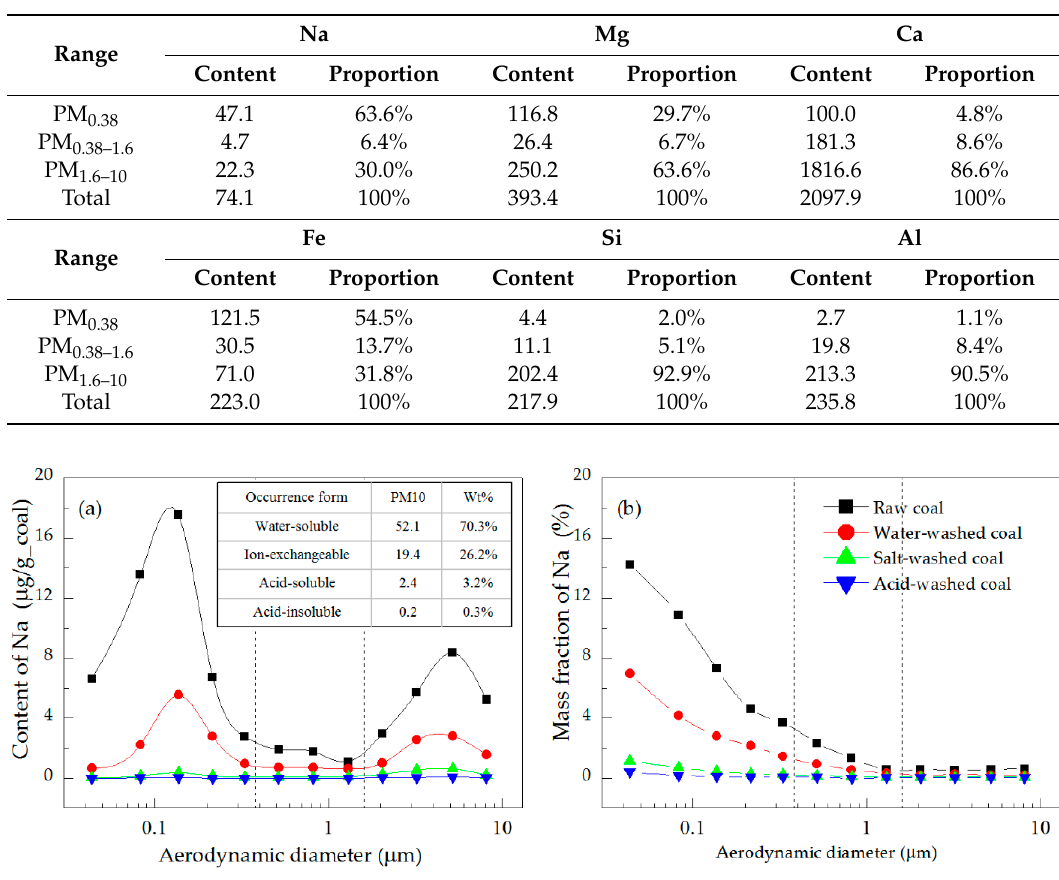
Figure 7. Distributions of the ( a ) content and ( b ) mass fraction of Ca in the PM. Figure 8a shows that the contributions of the water-soluble, ion-exchangeable, acid-soluble, and acid-insoluble Fe to PM 10 were 2.4%, 37.9%, 33.7%, and 26.0%, respectively. The distribution of the Fe content had peaks located in the ultrafine and coarse mode regions [21]. The peak value of the ultrafine mode area was higher for the PM emitted from the combustion of raw and water-washed coal; for the salt-washed coal, the two peaks were similar in size; and for the acid-washed coal, the peak value of the coarse mode area was higher. According to the difference in the contents and forms